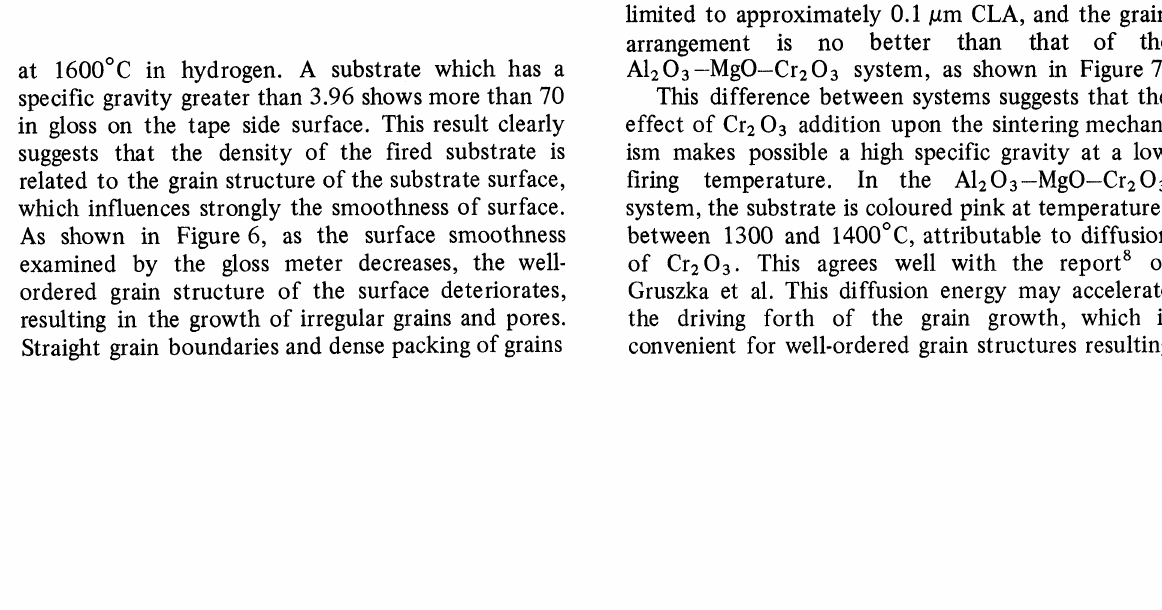
FIGURE 5 Relation between gloss of tape side and specific gravity of substrates fired at 1600C, 2 hours in